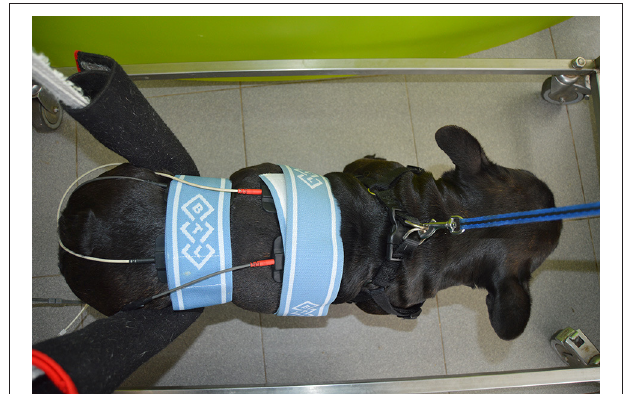
FIGURE 4 | Functional electrical stimulation (FES) through the sciatic nerve. Superficial electrodes applied in a segmental technique, placed on the sciatic nerve root (L7-S1 region) and near the flexor muscle motor